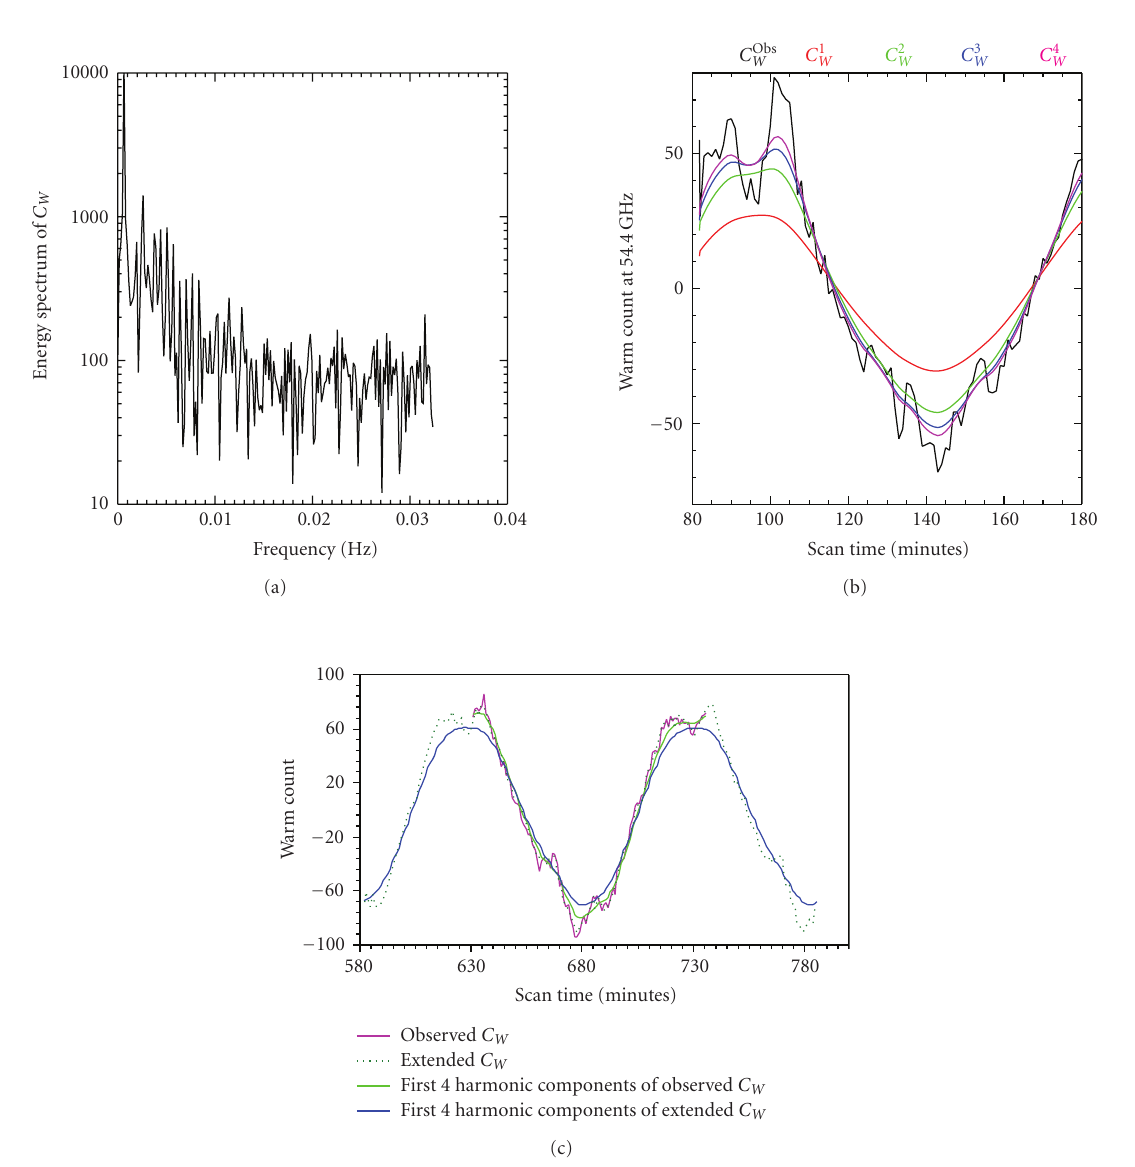
Figure 5: (a) FFT energy spectrum of C Obs at channel 4 (54.4 GHz) during one orbit of observations on March 20, 2006. (b) Time W ∼ C 4 , C 1 at 54.4 GHz for the same orbit as in (a). (c) Comparisons of C Obs series of C Obs W W W counts at 54.4GHz. In the figures, an orbital mean of corresponding counts has been subtracted from the warm counts in each orbit of